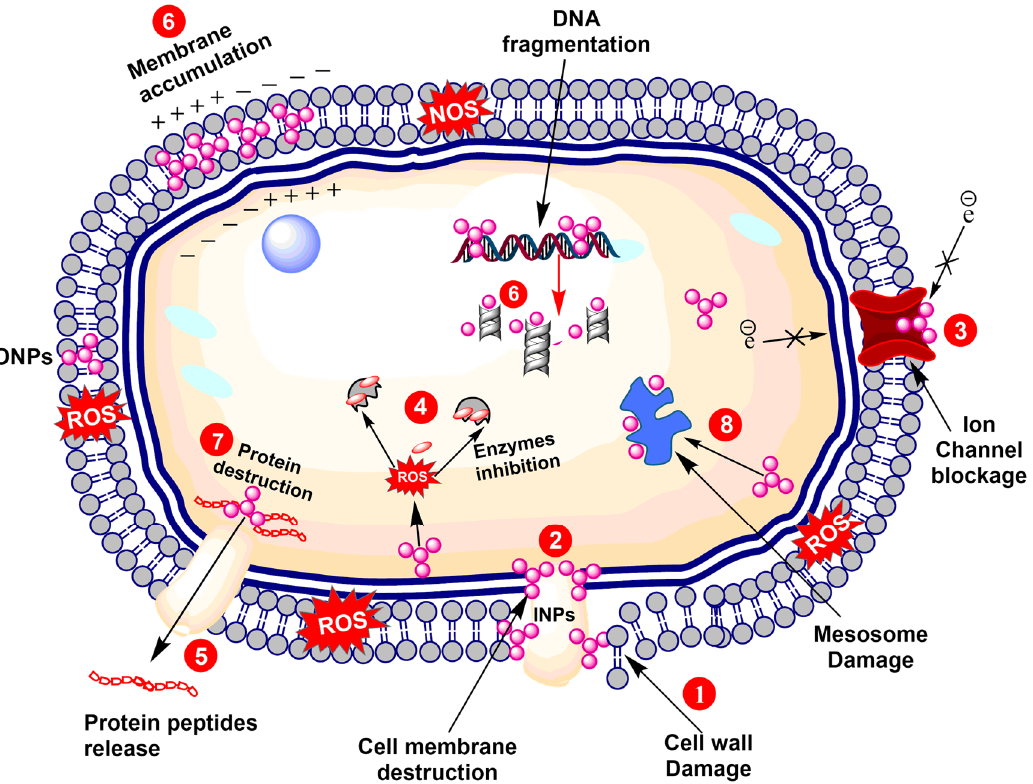
Figure 1. Antibacterial potential of iron nanoparticles (INPs). (1) Cell wall destruction via interfering the normal homeostasis; (2) Cell membrane damage is caused by disorientation of the lipid bilayer via ROS production; (3) Ion channel misconfiguration occurs when transporter proteins are dam- aged; (4) Enzyme physiology is disrupted via inhibition of their catalytic domains; (5) Nucleic acid is damaged leading to fragmentation of DNA and RNA; (6) Biomolecules disruption occurs, in par- ticular, in proteins and NPs; (7) Proteins denaturation via ROS; and (8) Organelles damage, in par- ticular, mesomes.